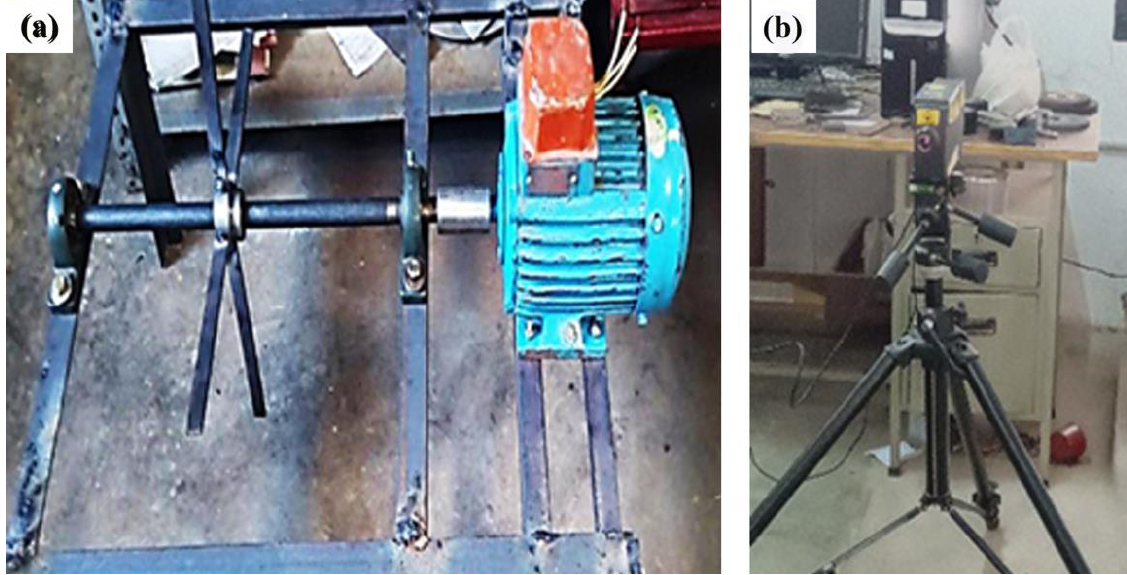
Figure 3. ( a ) Experimental rig and ( b ) laser vibrometer.